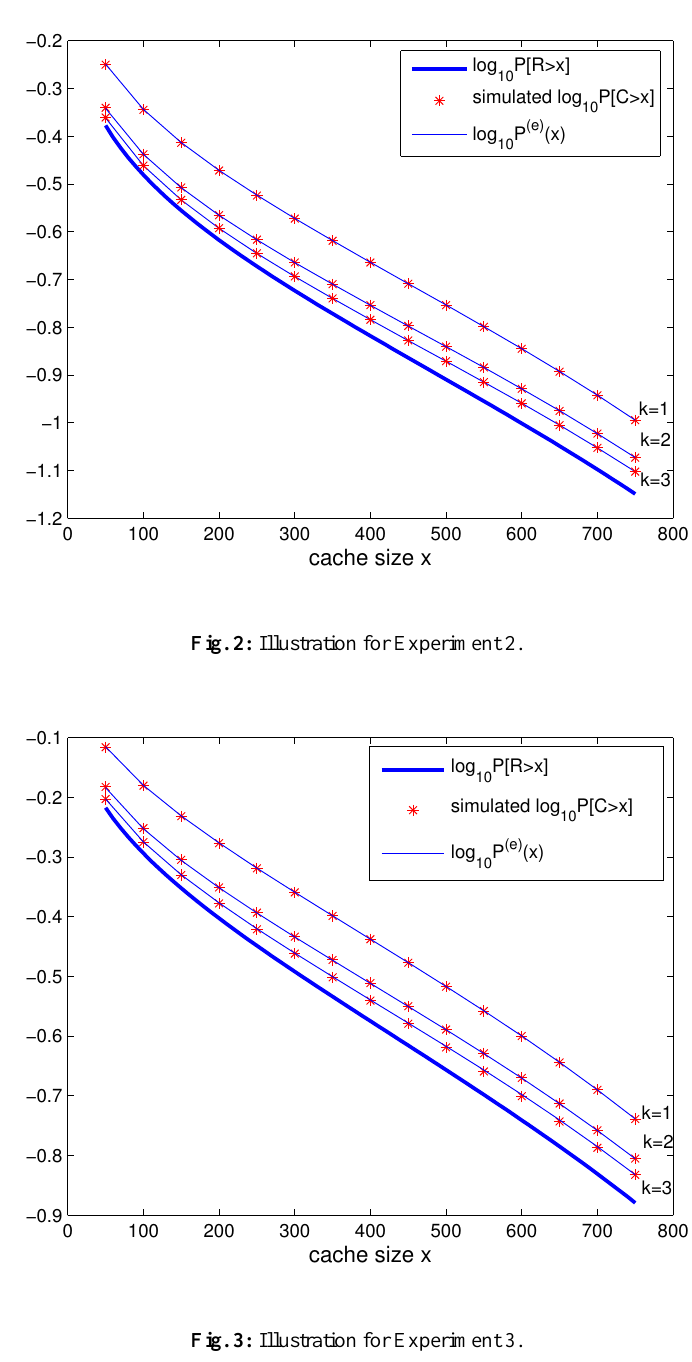
Fig. 3: Illustration for Experiment